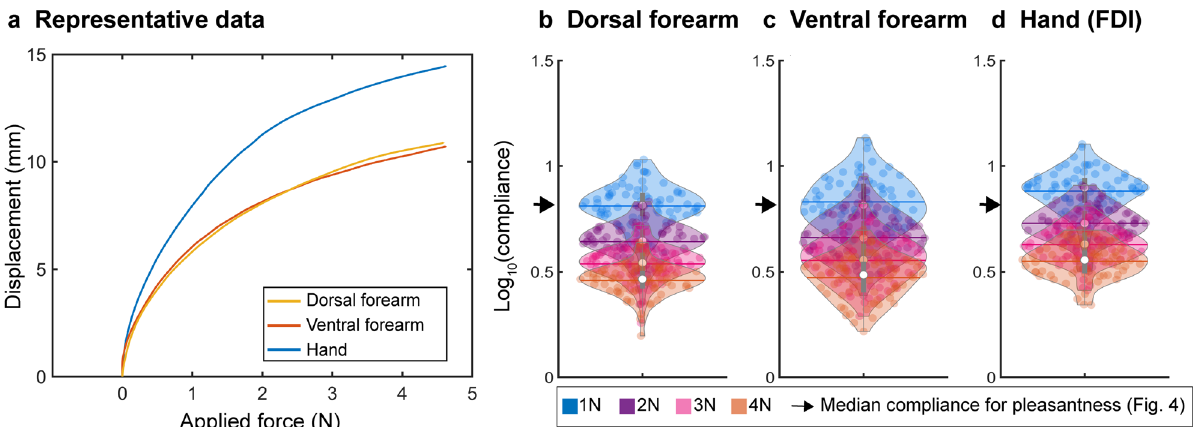
Figure 6. Distribution of compliance values for hands and forearms. We measured the forearm and hand compliance of 70 volunteers using the same setting as in Fig. 1b to measure body displacements with applied force. ( a ) Representative data. Unlike stimuli (Fig. 1b), the skin displacement did not increase linearly as a function of applied force. Compliance was determined as displacement per force at 1 N, 2 N, 3 N, and 4 N. ( b-d ) Distribution of compliance values for dorsal forearm, ventral forearm, and hand (n = 70) are shown as violin plots. The skin over the first dorsal interosseous (FDI) was used to measure hand compliance. Each dot represents the individual participant’s compliance at each force. The white circle, horizontal line, and bar indicate the median, mean, and box plot, respectively. Black arrows indicate the median compliance value for pleasantness (Fig.